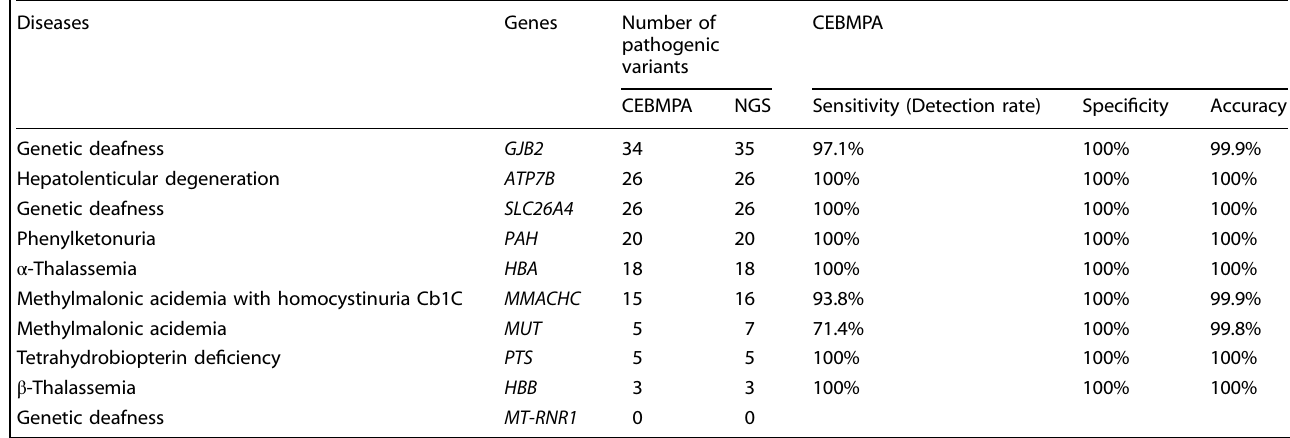
Table 1. Number of variants in overlapping genes imputed by NGS and CEBMPA in 1000 individuals.